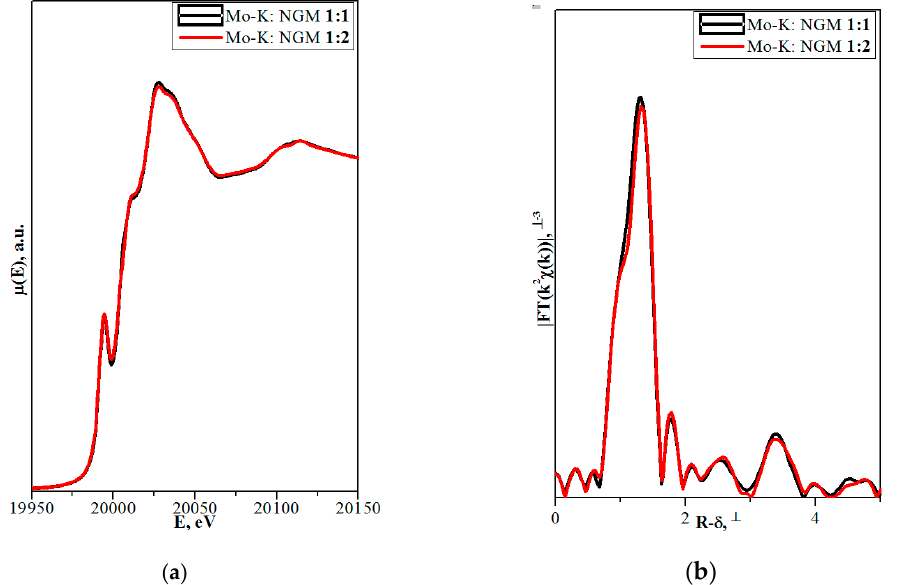
Figure 5. Mo K-edge-normalized ( a ) XANES spectra and ( b ) EXAFS Fourier transforms for NGM 1:1 (black curves) and NGM 1:2 (red curves) samples.